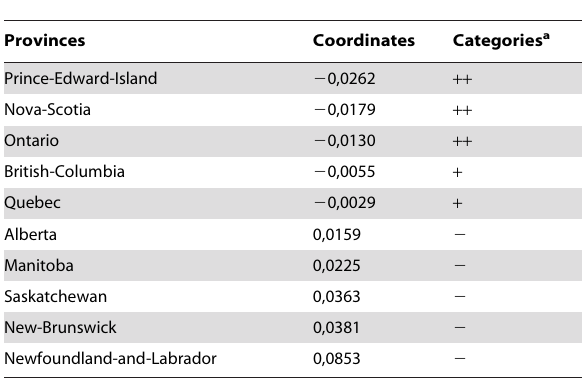
Table 3. Provinces’ coordinates on the Indoor Index, 2007.